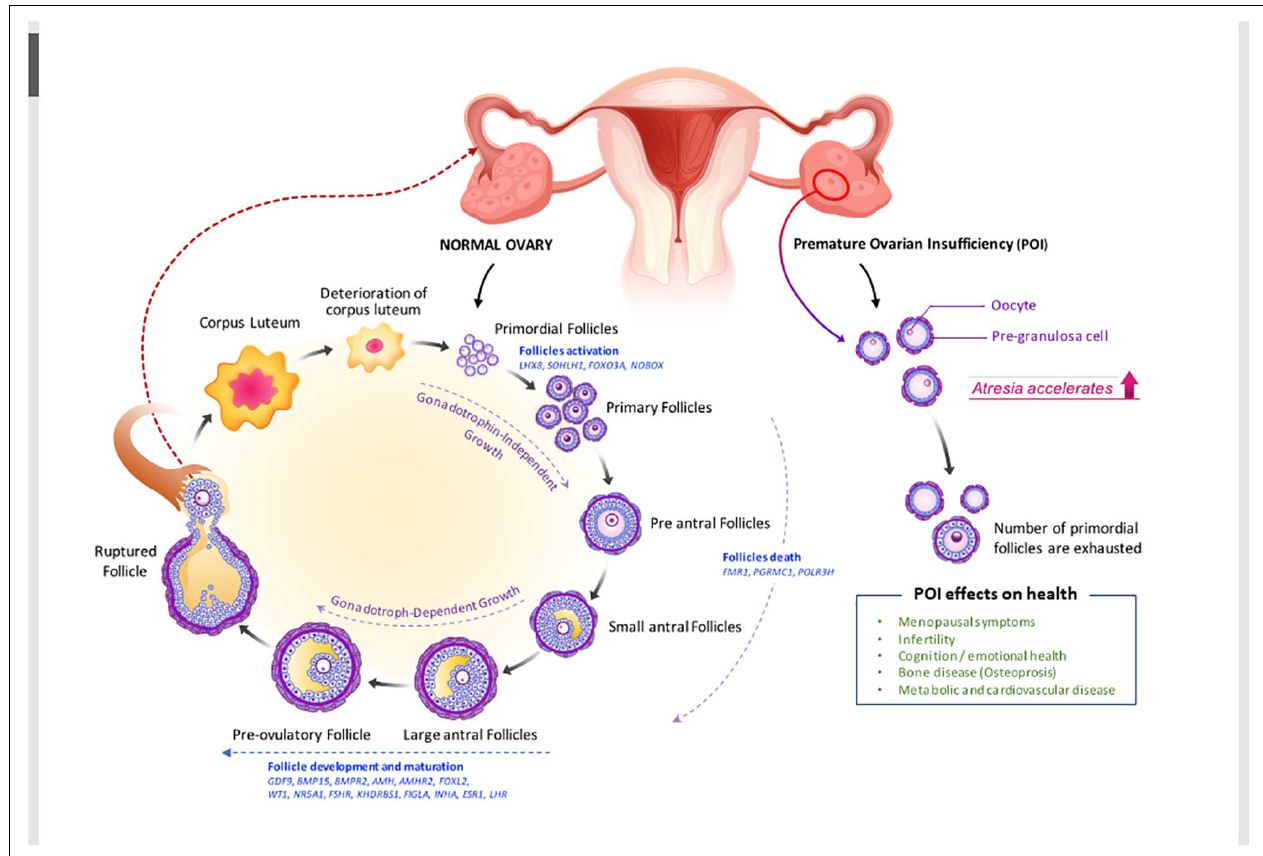
FIGURE 1 | Folliculogenesis and ovulation in normal ovary versus POI ovary (impaired folliculogenesis). Under the regulation of intraovarian factors and gonadotropins, primary follicles develop into preantral and early antral follicles, which are the most susceptible to atresia, or follicle death. Then, they become preovulatory follicles, resulting in oocyte release and corpora lutea formation. Defects in folliculogenesis (e.g., decrease in primordial follicles, increase in atresia, and altered follicular maturation) causes POI. Selected genes that are involved in ovarian follicle activation, maturation, and death and the effect of POI on health (see also in Table 2 and section “Clinical view of POI”) are shown. AMHR2, anti-Müllerian hormone receptor 2; BMP15, bone morphogenic protein 15; BMPR2, bone morphogenetic protein receptor 2; FMR1, fragile X mental retardation; FSHR, follicle-stimulating hormone receptor; FOXO3A, forkhead box O3; FOXL2,